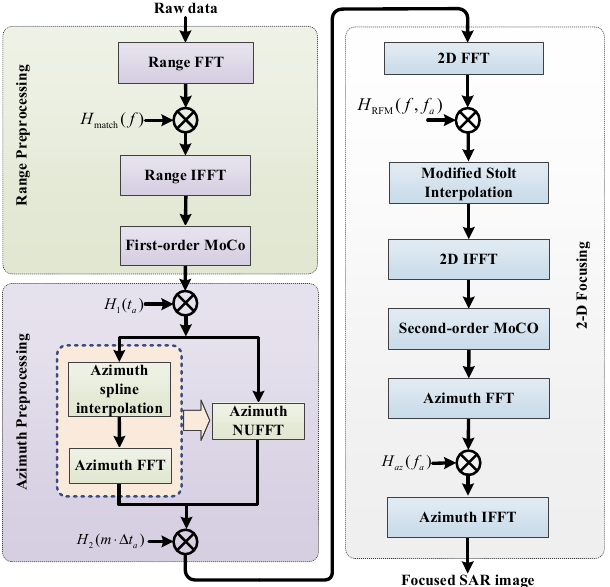
Figure 8. Block diagram of the modified RMA processor for the proposed mode.